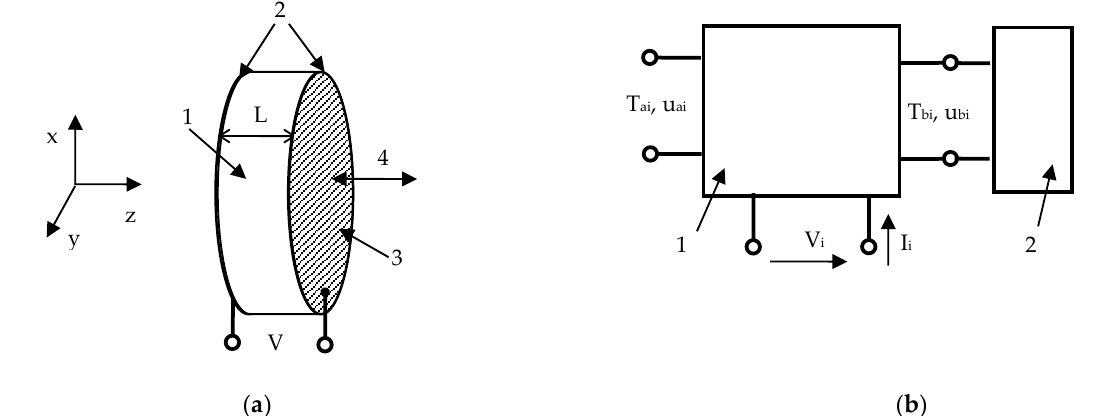
Figure 2. ( a ) Schematics of the longitudinal piezoelectric transducer: 1 — piezoceramic disk, 2 — metal electrode plates, 3 — working surface of the transducer, displacement directions, 𝑉 — applied rf voltage; ( b ) six-pole network model (1) for the transducer with an acoustic load (2).